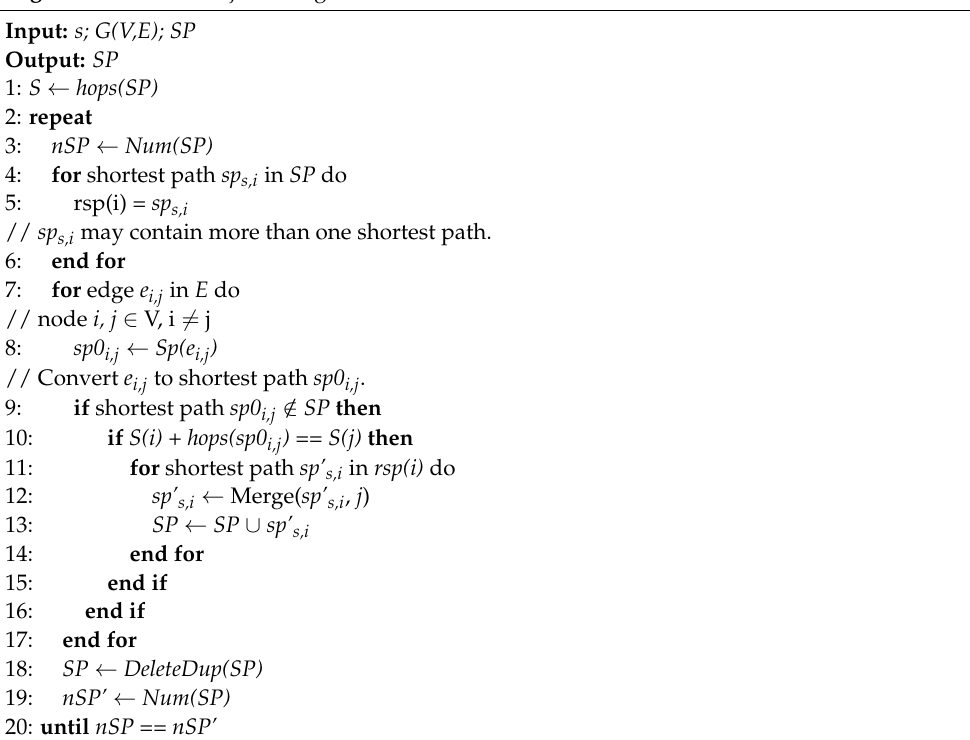
Algorithm 2 ECMP-Dijkstra